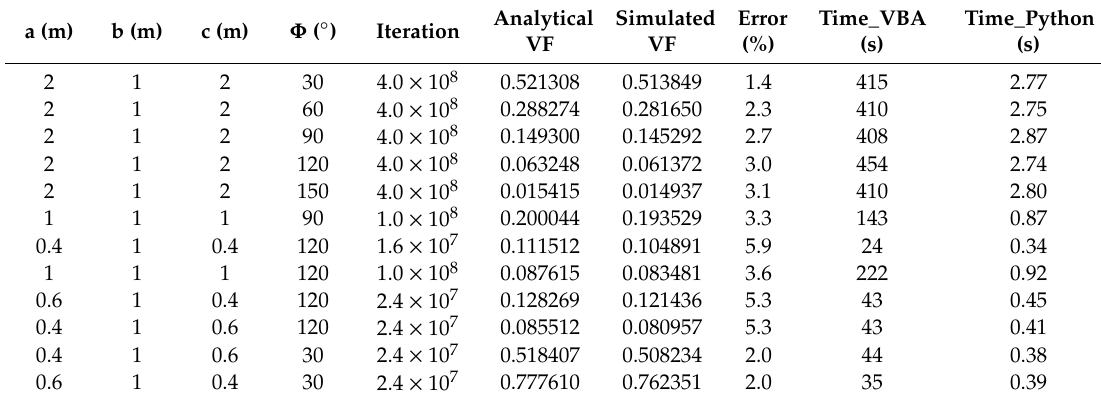
Table A1. View factor simulation data for element size h i = 0.01 m.